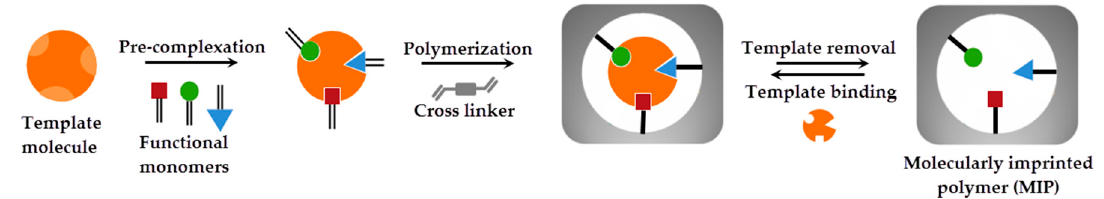
Figure 1. The steps of the molecularly imprinted polymer (MIP) preparation.